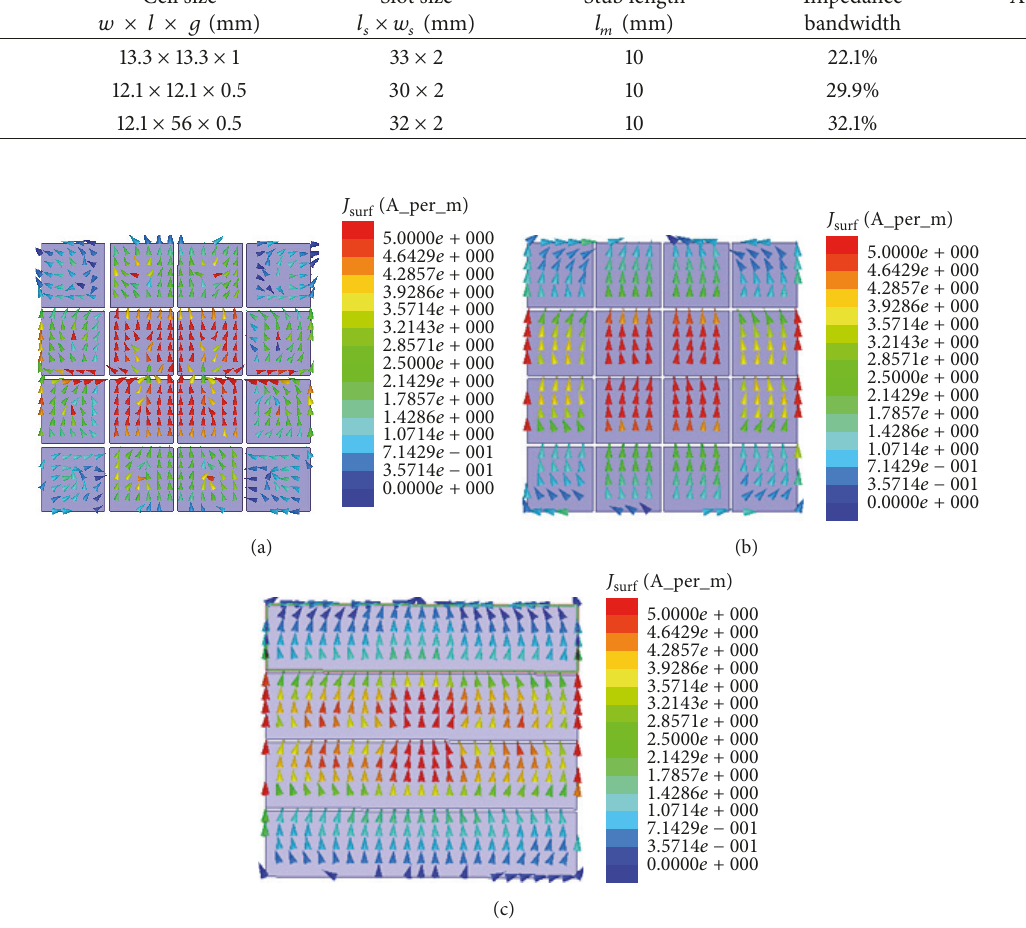
Figure 3: Simulated surface current distributions on MPs at 5 GHz. (a) MP I. (b) MP II. (c) MP